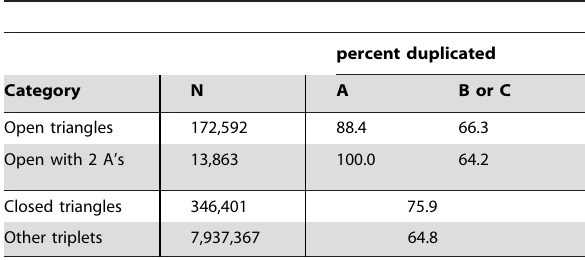
Table 3. Percentages of duplicated genes among different